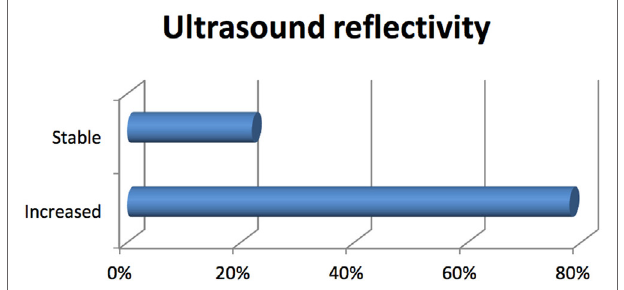
FIgURe 11 | Local control response by ultrasound